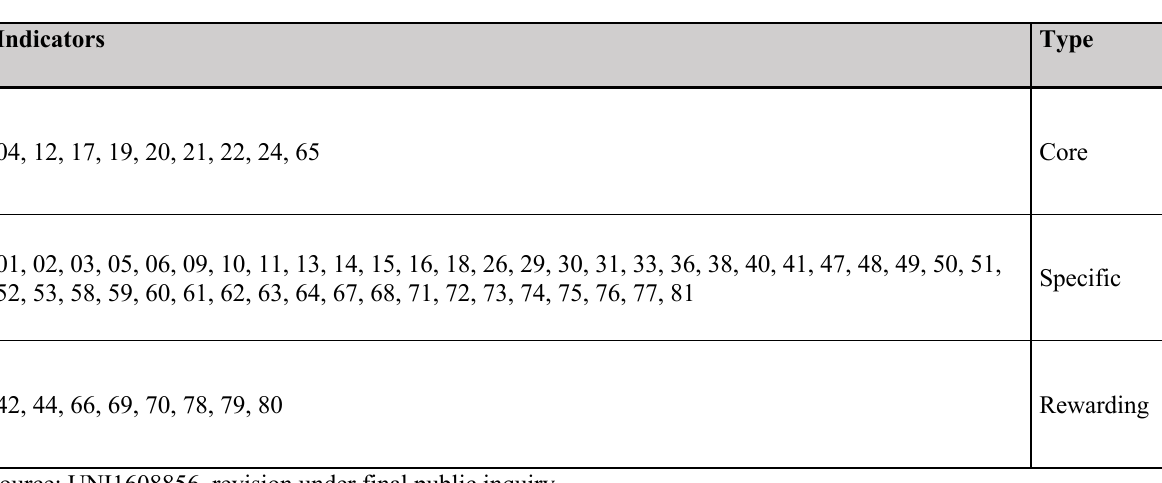
Table II. Calculation schema for the evaluation of a service industry, as applied in the UPO case